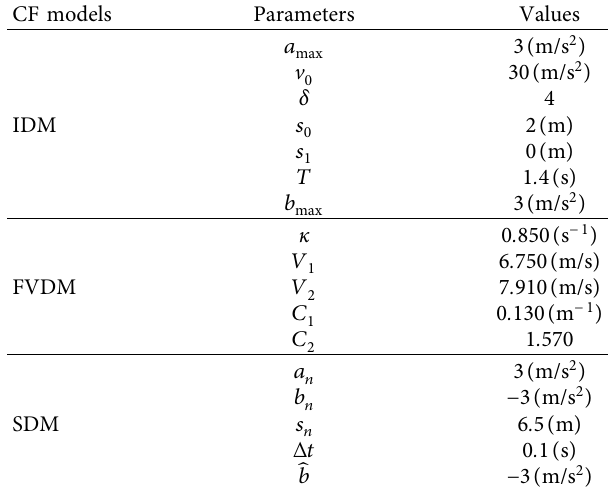
Table 1: Values of diferent parameters in CF models. CF